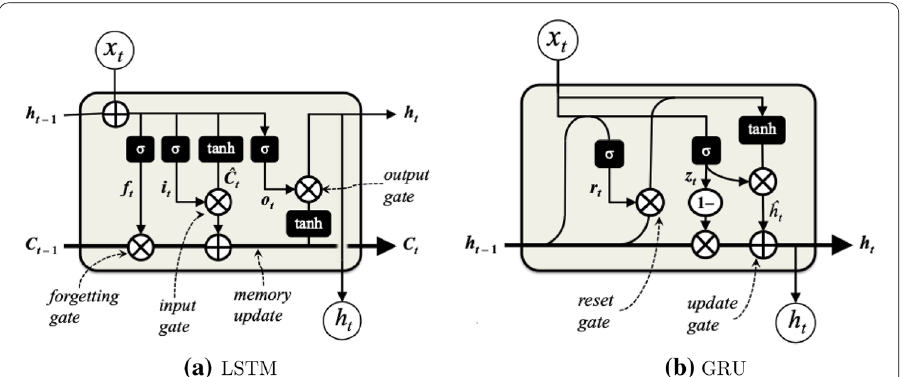
Fig. 3 Structure of the LSTM and GRU blocks and their